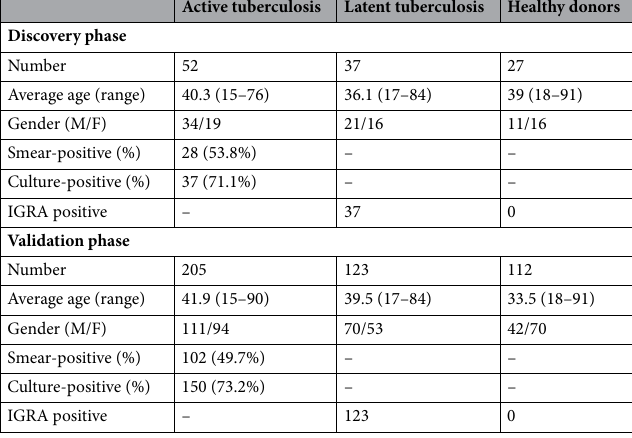
(Fig. 3a green bar chart). Biological process enrichment analysis of differential proteins identified in the ATB-vs-LTBI comparison indicated that processes related to interspecific interactions showed significant enrichment (Fig. 3a). In the ATB-vs-HC comparison, differential proteins were significantly enriched in biological processes related to the chelation and transport of metal ions ( p < 0.05), the three most enriched biological processes being pathogenesis, iron ion transport, and iron assimilation (Fig. 3a). We used STRING analysis of protein–protein interaction networks to determine which differential proteins from the ATB-vs-LTBI and ATB-vs-HC comparisons were important in the functional network. Key proteins included Rv1827, Rv1860, Rv3413, Rv0934, Rv3803c, and Rv3881c (ATB-vs-LTBI comparison; Fig. 3b left panel), and Rv3881c, Rv0064, Rv1827, Rv1860, and Rv0934 (ATB-vs-HC comparison; Fig. 3b right panel). Although